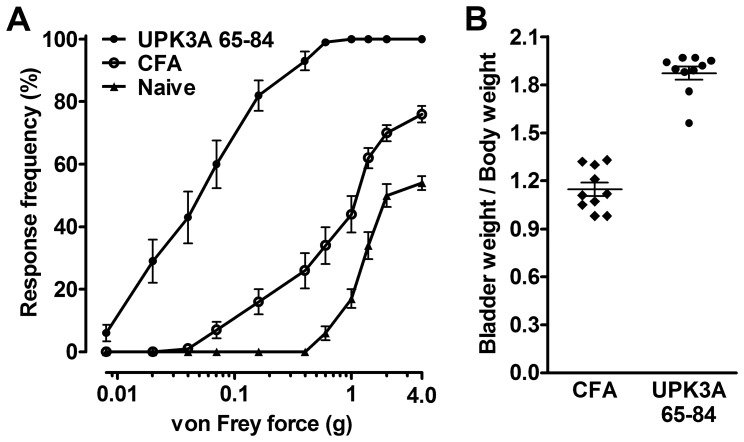
Pelvic hyperalgesia and increased bladder weight in mice immunized with UPK3A 65–84.(A) Pain responses were assessed by application of von Frey filaments to the suprapubic pelvic region in mice 5 weeks after immunization with UPK3A 65–84 or CFA, or in naïve mice (n = 10 per group). The response frequencies (percentage of positive responses out of 10 stimuli) to increasing filament forces were plotted, and 50% threshold forces were calculated as described in Methods. Mice immunized with UPK3A 65–84 exhibited significantly higher sensitivity (lower 50% thresholds, 0.059±0.046 g) in responding to suprapubic application of von Frey filaments, as an indicator of pain referred from the bladder, compared with CFA-immunized mice and naïve mice (1.1±0.56 g and 2.9±0.78 g, respectively; p<0.0001 in both comparisons by one way ANOVA of log-transformed 50% thresholds with Tukey’s multiple comparisons test). In the same analysis, the 50% thresholds of CFA-immunized and naïve mice also differed significantly from each other (p<0.01). (B) Ratios of bladder weight (mg) to body weight (g) were significantly higher in mice immunized with UPK3A 65–84 compared to CFA-immunized controls (p<0.0001 by unpaired t test). Error bars indicate plus and minus SEM.